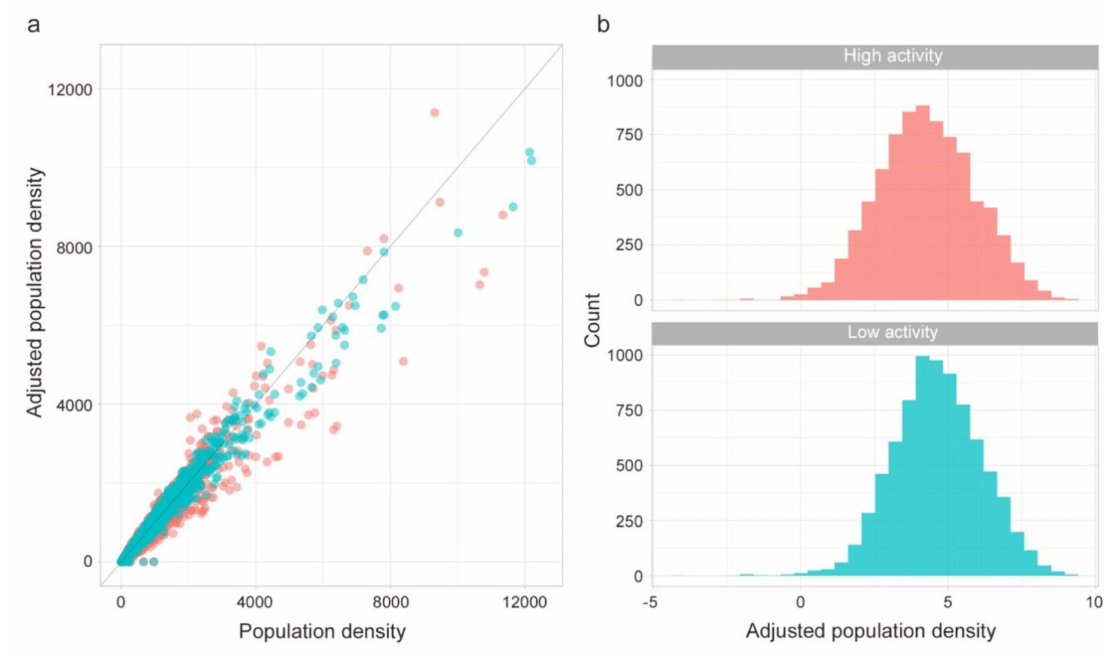
Figure 5. ( a ) Population density adjustment and ( b ) adjusted population density distribution for low activity time (blue) and high activity (red)